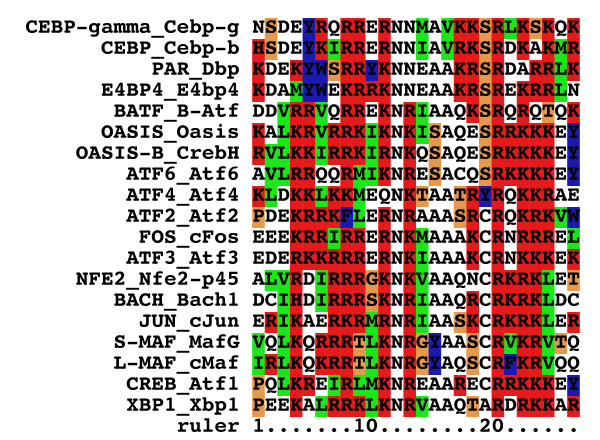
Multiple alignment of the DNA-binding BR of human bZIPs. Each protein sequence is a representative of a bZIP family. The first part of the protein name designates the family, while the second part designates the specific protein. The sequences are coloured by residue, using the default colouring scheme of ClustalX.